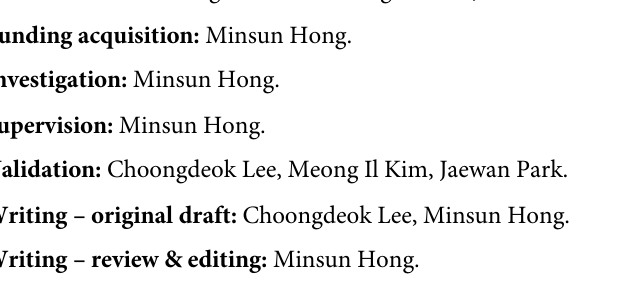
S1 Table. Crystallographic statistics of the LftR